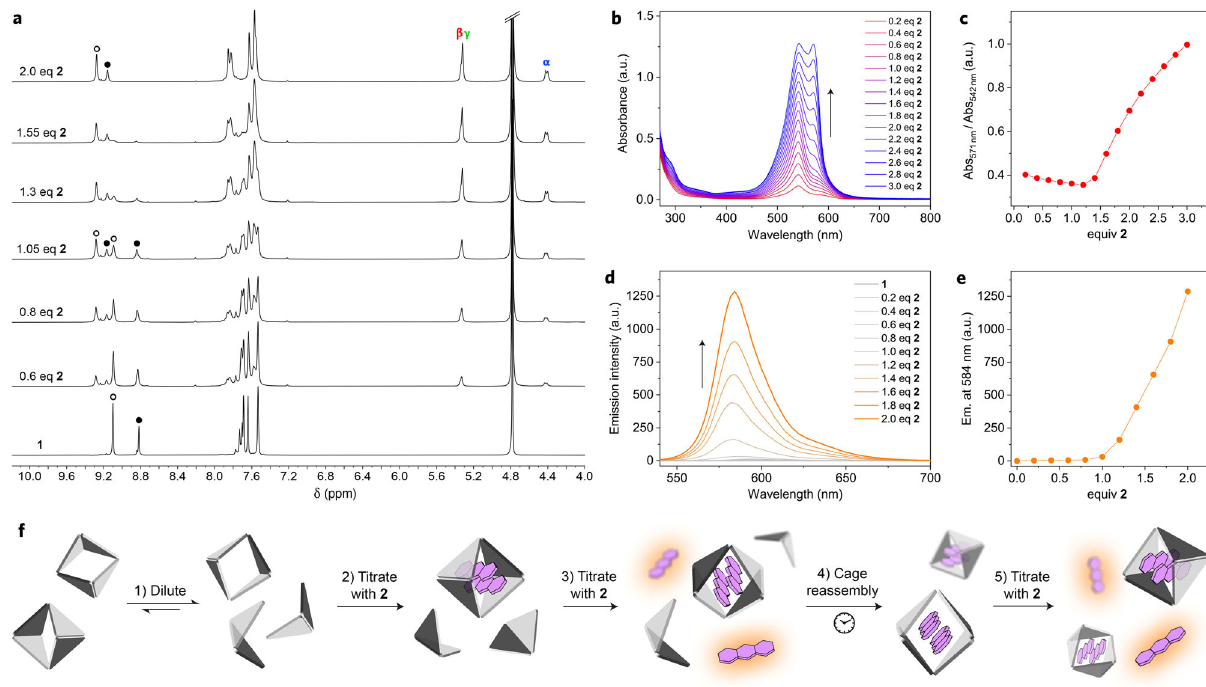
Fig. 3 Reversible disassembly and guest-templated reassembly of cage 1. a Bottom to top: 1 H NMR spectra of cage 1 in the presence of increasing amounts of guest 2 (deprotonated with excess TMEDA) (400 MHz, D 2 O, 298 K). b UV-Vis absorption spectra of cage 1 in the presence of increasing amounts of 2 . c Changes in the ratio of Abs 571nm (high for 2 ; low for 2 2 ⊂ 1 ) to Abs 542nm (high for 2 2 ⊂ 1 ; low for 2 ) as a function of the amount of 2 added. The sharp increase of Abs 571nm /Abs 542nm at ~1.4 equiv 2 indicates that 2 added at that point is not complexed. d A series of fl uorescence spectra ( λ exc = 530 nm) accompanying the titration of cage 1 with 2 . e Following the emission at 584 nm (due to uncomplexed 2 ) as a function of the amount of 2 added. The sharp increase of emission at ~1.2 equiv 2 indicates that the added 2 is not complexed. f Cartoon representation of fl uorescence fl uctuations during the titration of a dilute solution of cage 1 with 2